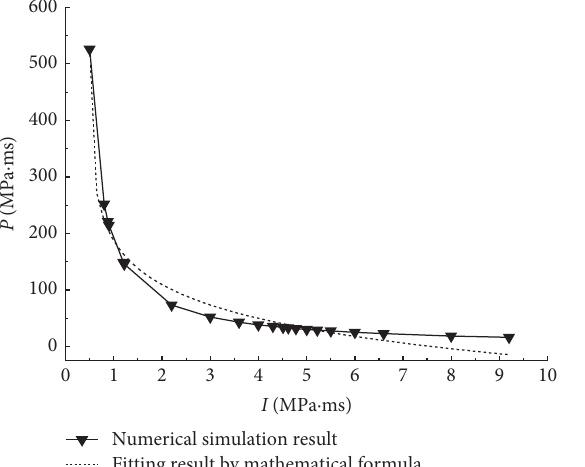
Figure 22: Comparison between fit pressure-impulse (P-I) curve and the numerical simulation for the CFDST column.